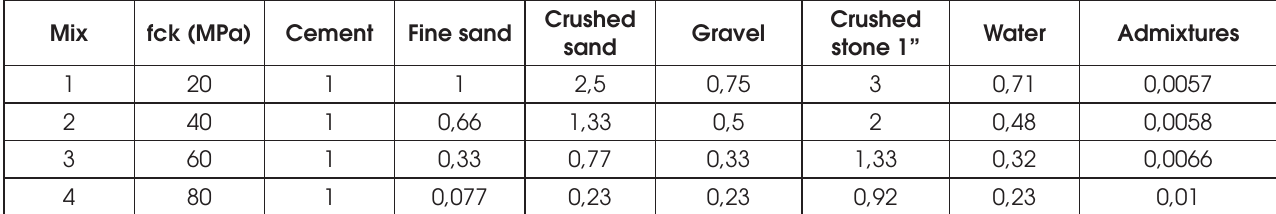
Concrete mix design